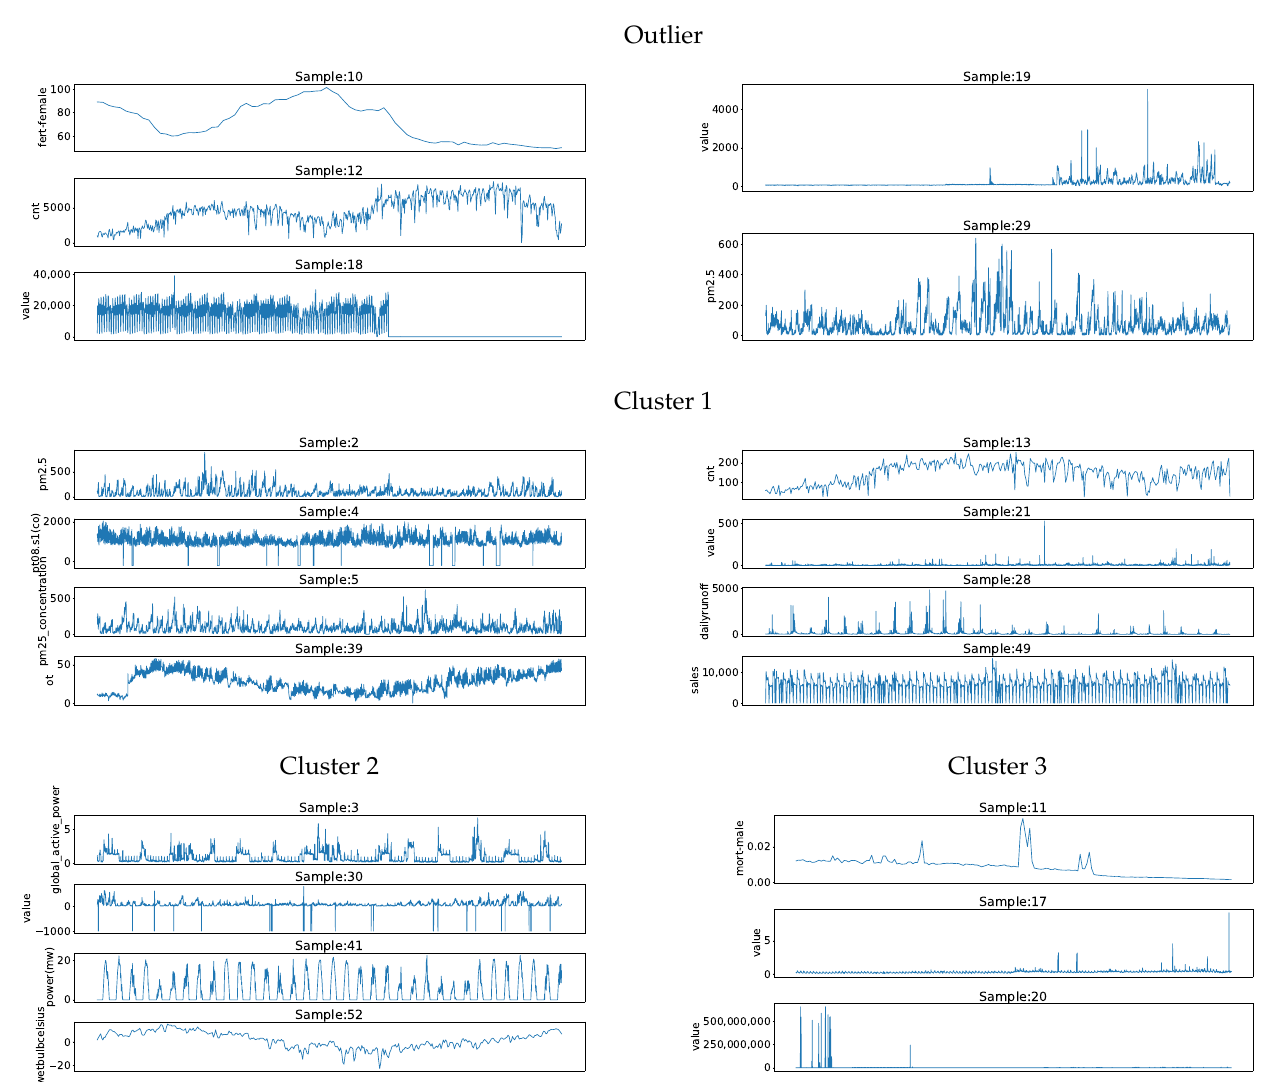
Figure 5. Samples from all dataset from Table 6 with a maximum length of 100